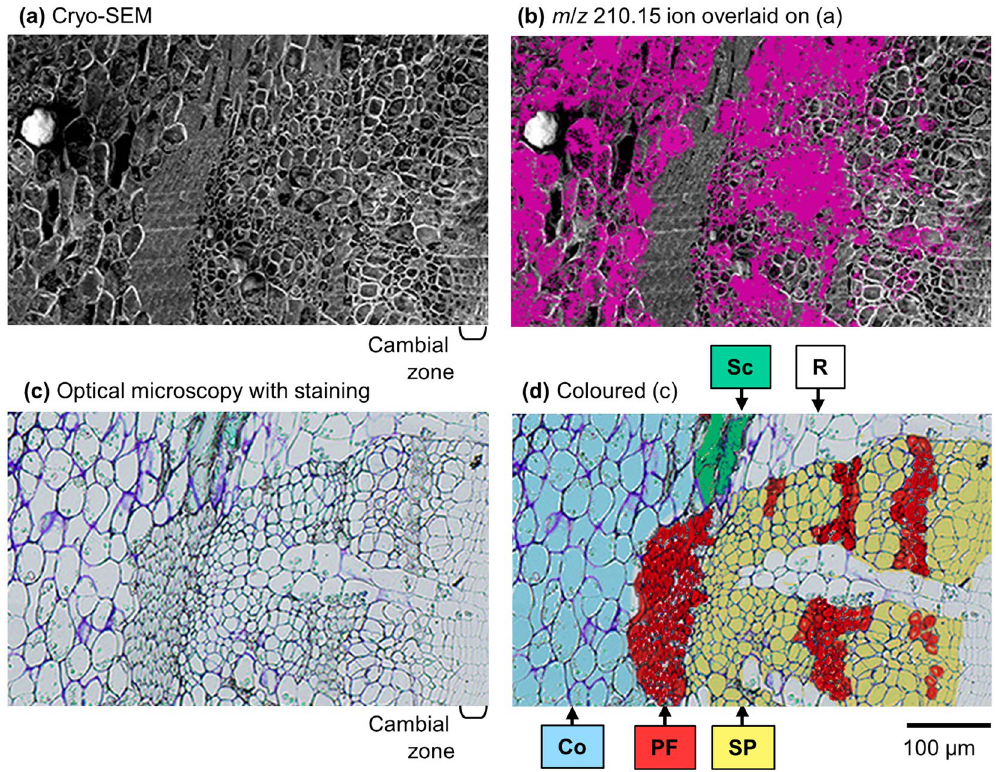
Figure 4. Images obtained by ( a ) cryo-SEM and ( b ) overlay of cryo-TOF-SIMS m / z 210.15 ion (red) on the cryo-SEM image, illustrating the distribution of salicifoline in the freeze-fixed stem of M. kobus . Nearly the same region was observed by ( c ) optical microscopy with toluidine-blue staining, and the assigned tissues were separately coloured to distinguish them ( d ). Letters in d show the positions of cortex (Co), phloem fibre (PF), sclereid (Sc), secondary phloem (SP), and ray cells (R). Scale bar is 100 μ